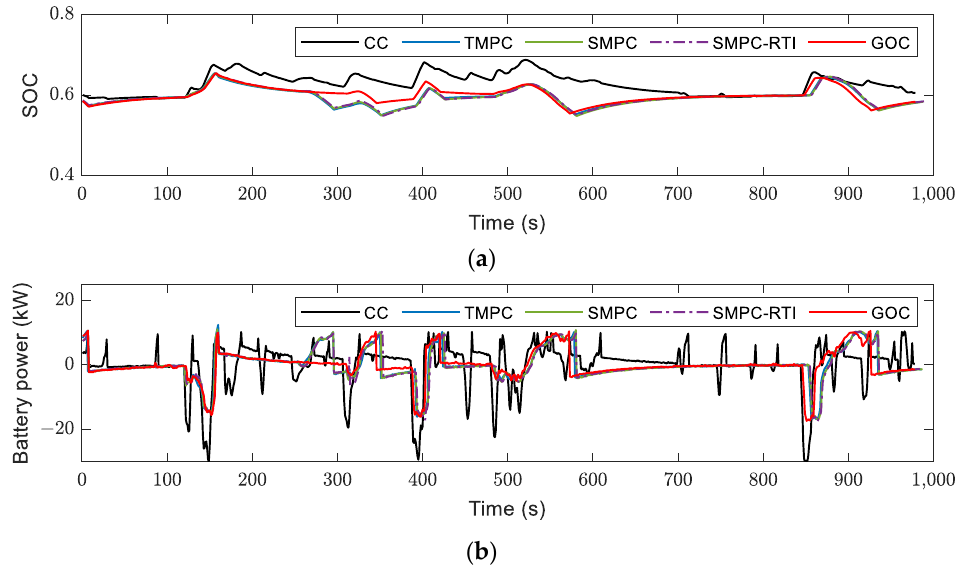
Figure 13. SOC and battery power of the EC using different speed controllers: ( a ) SOC, ( b ) battery power. Table 4. Initial and terminal SOC of the EC using different speed controllers.